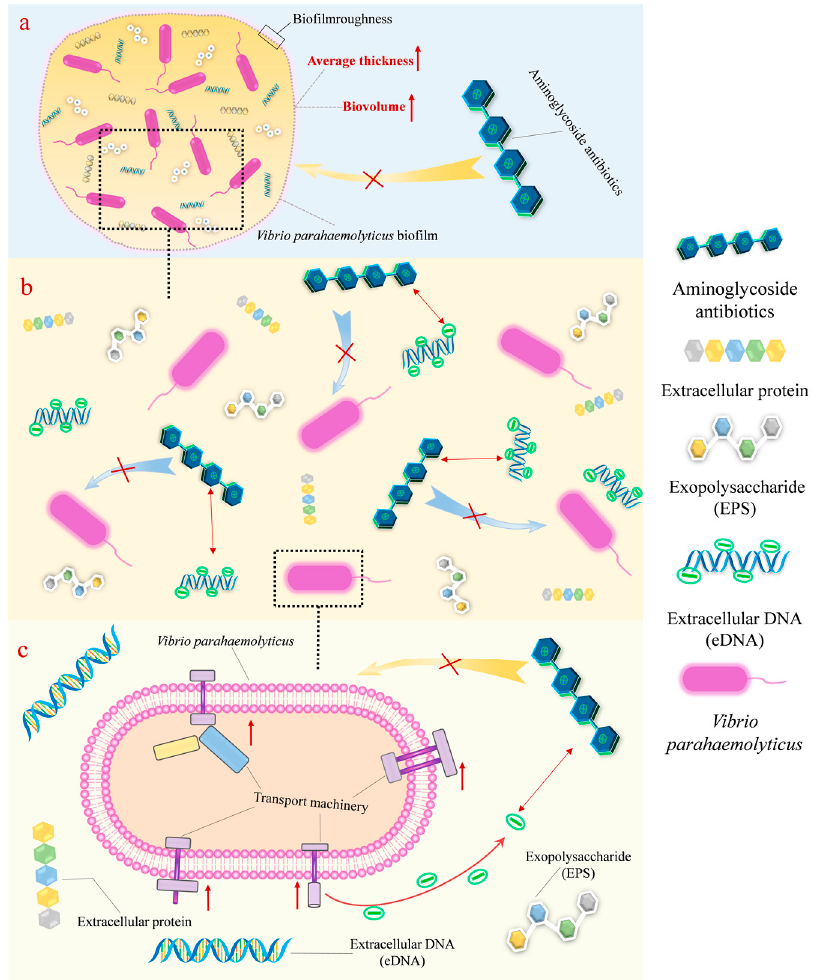
Figure 9. New mechanisms of biofilm resistance to aminoglycoside antibiotics. ( a ) Enclosure mechanism; ( b ) neutralization mechanism; ( c ) regulatory mechanism.